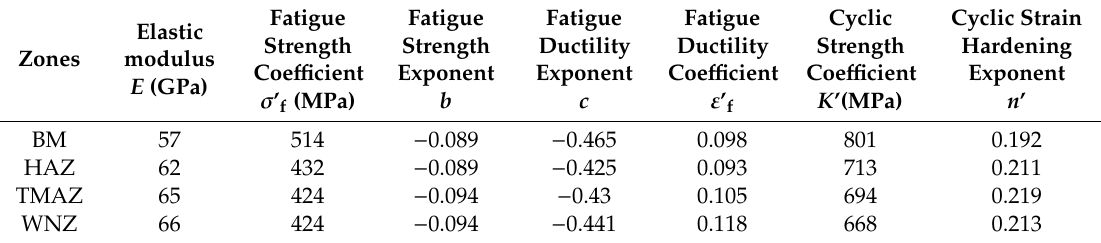
Table 1. Fatigue parameters of the welded joint.